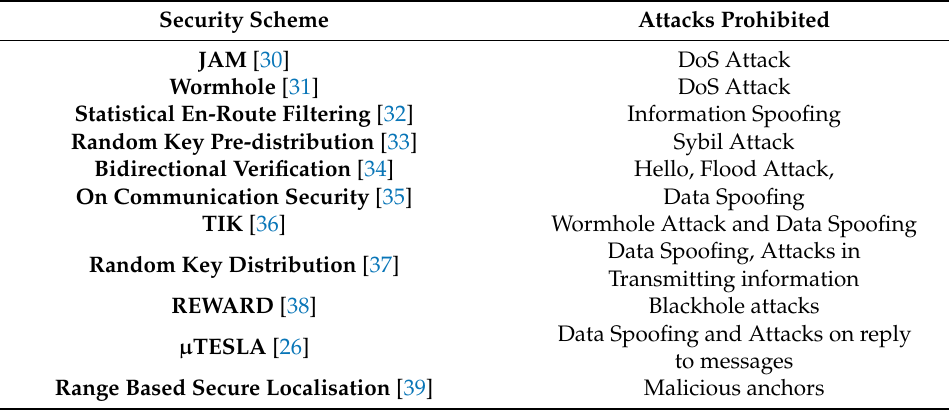
Table 2. Classification of attacks, with their consequences. Security Scheme Attacks